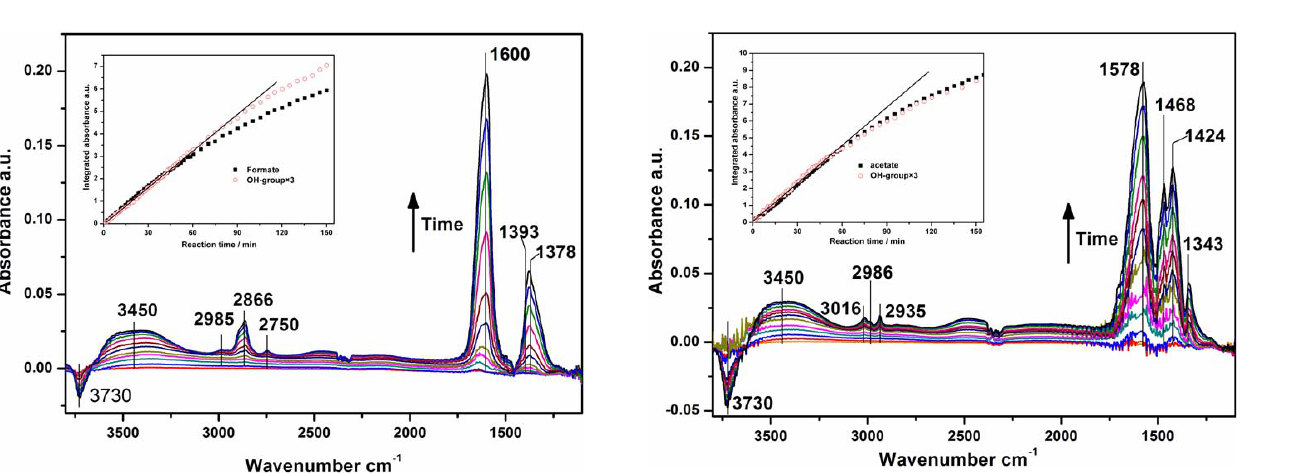
Fig. 1. Absorption spectra recorded during the reaction of HCOOH ([HCOOH] 0 =1.23 × 10 14 moleculescm − 3 ) on α -Al 2 O 3 particles. The inset shows the temporal evolution of the integrated absorbance of the formate absorption band (1250–1450cm − 1 ) and the OH ab- sorption band (3600–3800cm − 1 ).